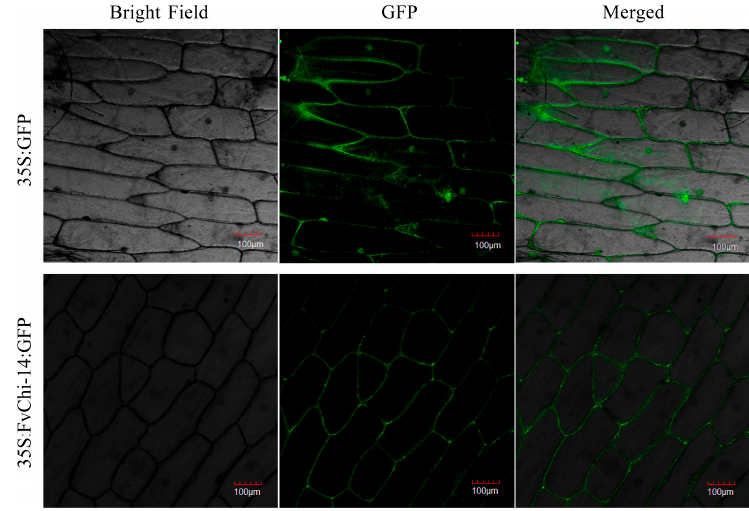
Figure 8. Subcellular localization of FvChi-14 in onion epidermal cells. Scale bar: 100 µm.